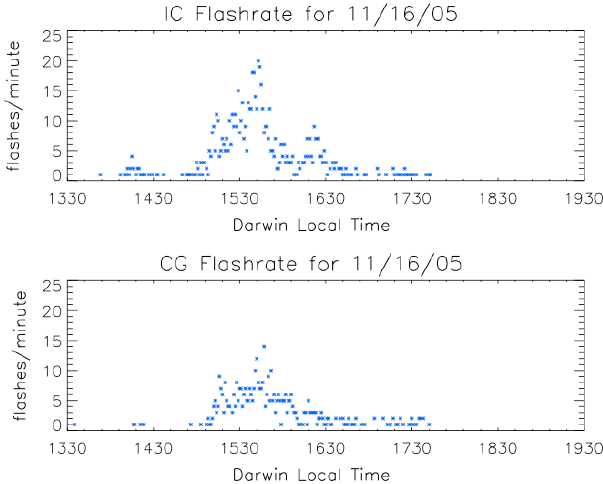
Fig. 5. Time series of IC and CG flashes per minute for 13:30– 19:30LT for the selected Hector